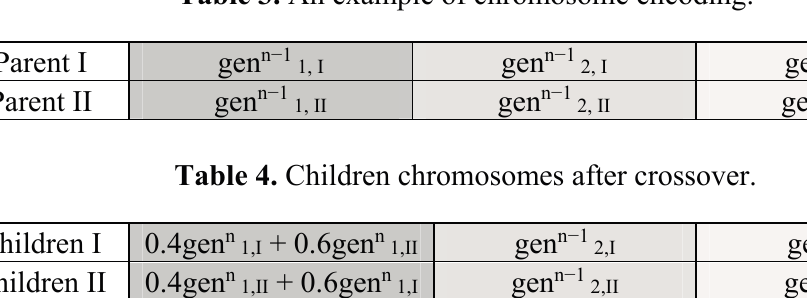
Table 3. An example of chromosome encoding.